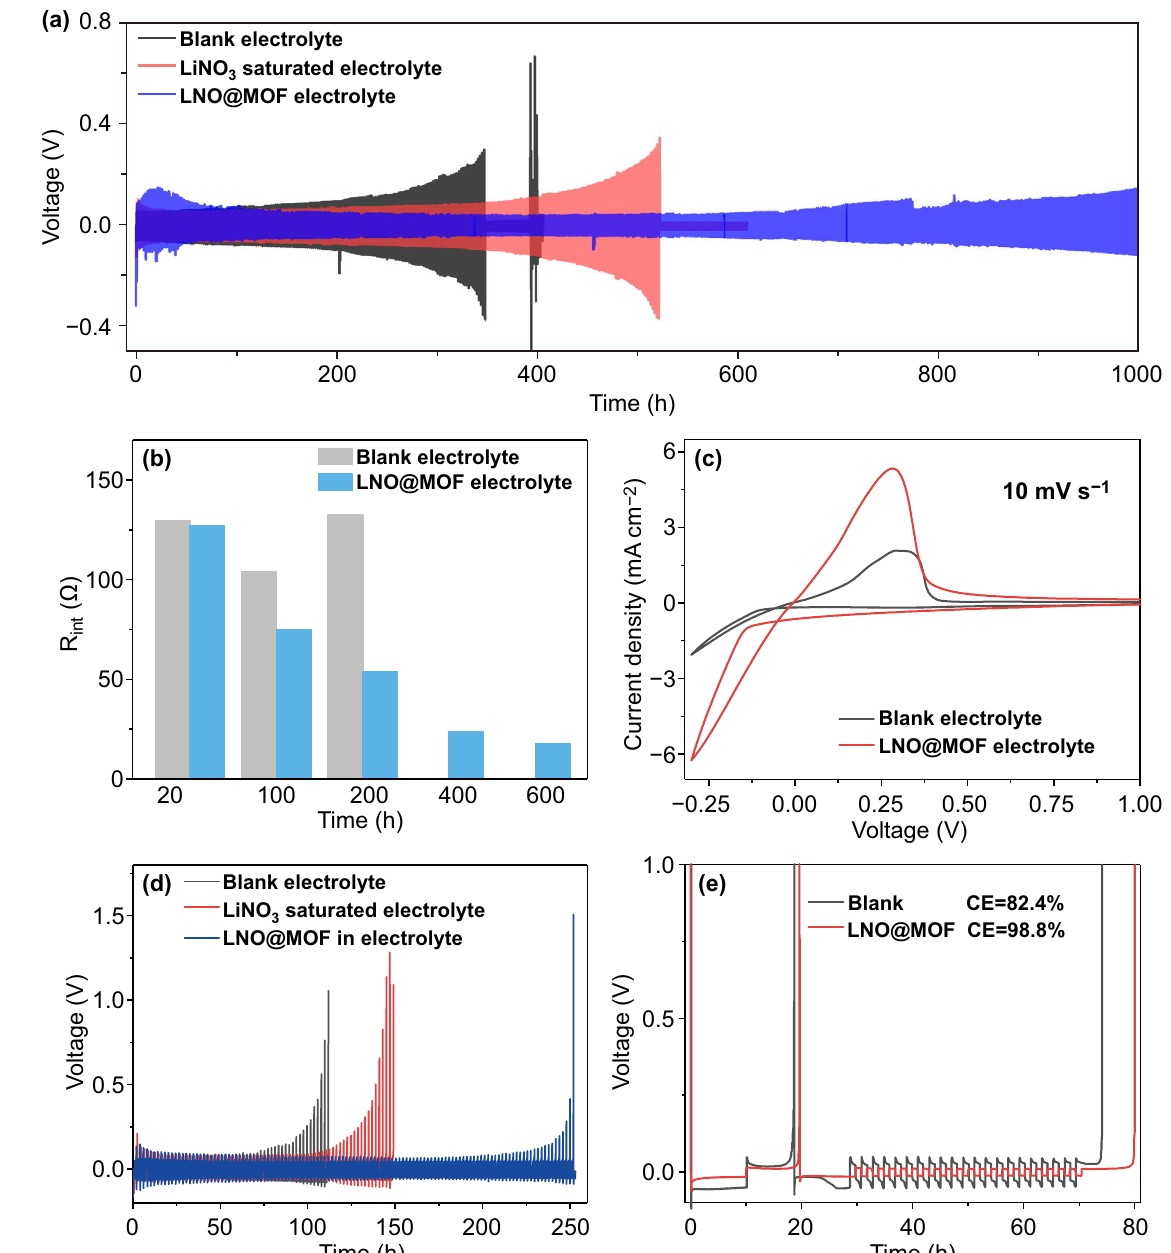
Fig. 2 a Voltage profiles of Li|Li symmetric cells at 1.0 mA cm −2 to a capacity depth of 1.0 mAh cm −2 and b R int of Li|Li symmetric cells dur- ing cycling obtained from Nyquist plot. c CVs of Cu|Li cells with blank and LNO@MOF electrolytes at a scan rate of 10 mV s −1 . d Voltage pro- files of asymmetric 50 μm-Li|Li cells at 1.0 mA cm −2 with a cycled capacity of 1.0 mAh cm −2 . e Voltage–time profiles to calculate the average Coulombic efficiency of LMA at 0.5 mA cm